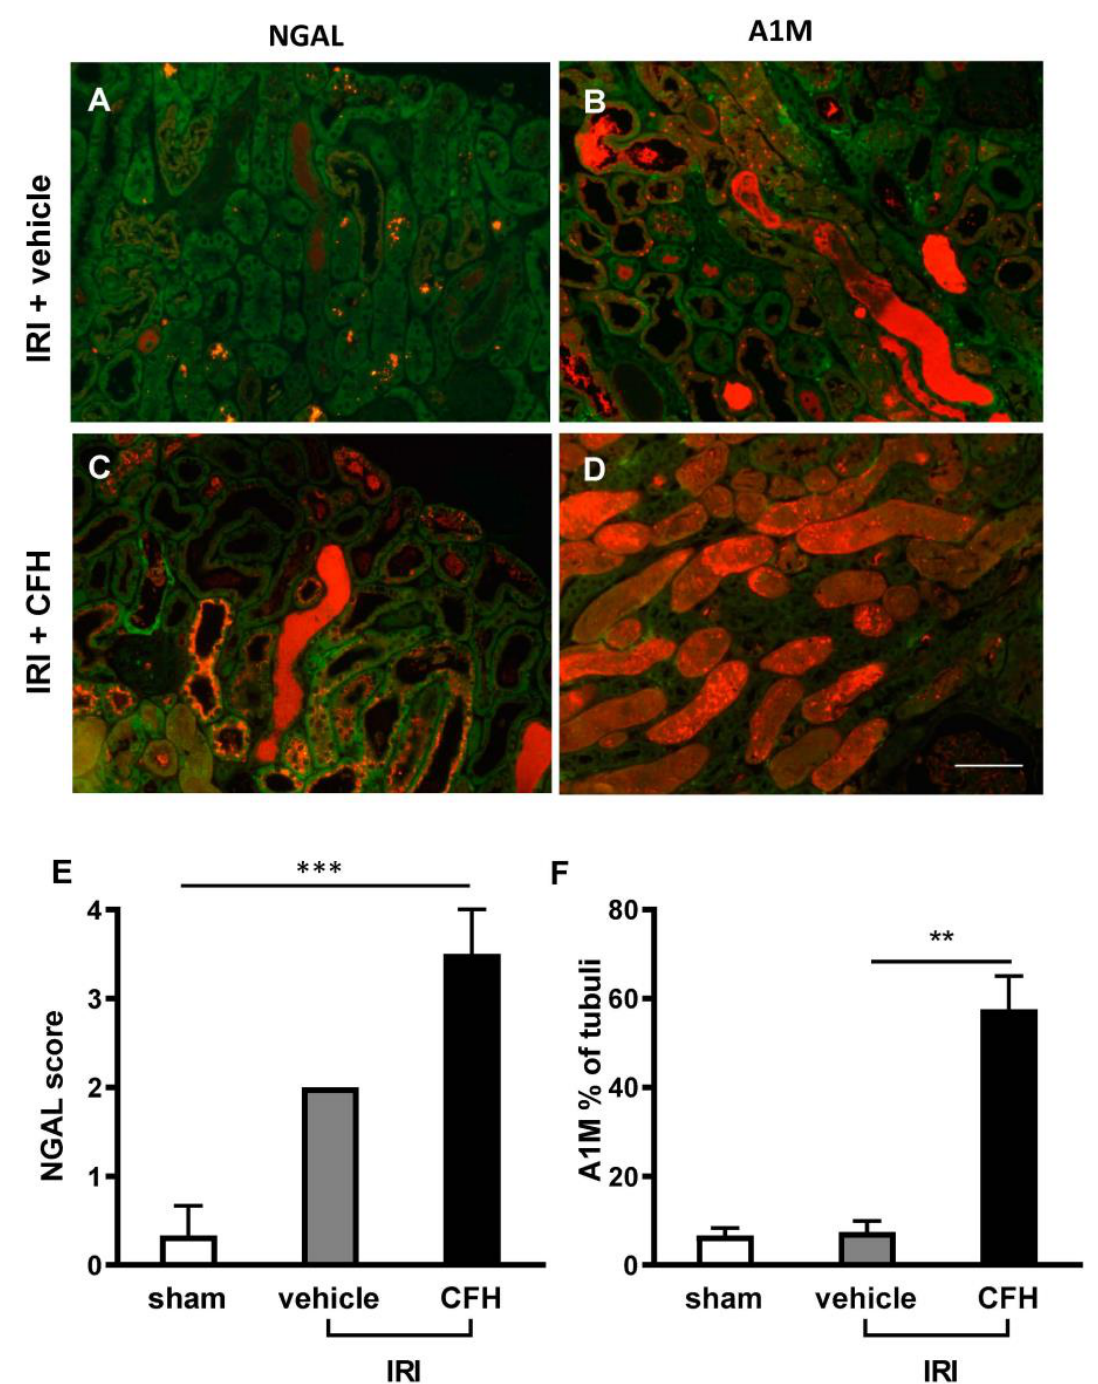
Figure 3. Kidney immunofluorescence staining for the renal injury marker NGAL ( A , C ) and the tubular transport marker A1M ( B , D ) in mice 48 h after IRI with or without CFH administration. Autofluorescence of renal tubuli is displayed in green; the NGAL or A1M staining signal is displayed in orange. Renal IRI and vehicle treatment only induced minor tubular NGAL staining ( A , E ). IRI + CFH resulted in significant increase in tubular NGAL staining ( C , E ). Tubular transport function was only slightly impaired in renal IRI and vehicle treatment as indicated by A1M tubular cast formation ( B , F ). However, CFH administration in mild renal IRI caused severe impairment of tubular transport function as evidenced by significantly increased A1M cast staining ( D , F ). ** p < 0.01, *** p < 0.001. Scale bar 100 µm.